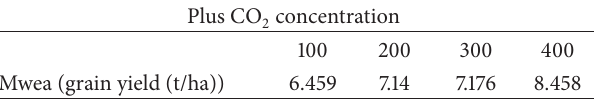
Table 8: Variation in basmati 370 grain yield in Mwea irrigation concentration. scheme under SRI with increase in atmospheric CO 2 Plus CO concentration 2 100 200 300 400 Mwea (grain yield (t/ha)) 6.459 7.14 7.176